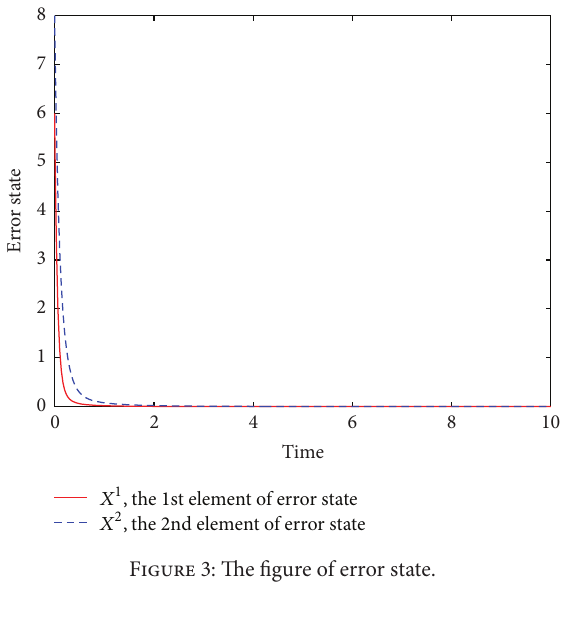
Figure 3: The figure of error